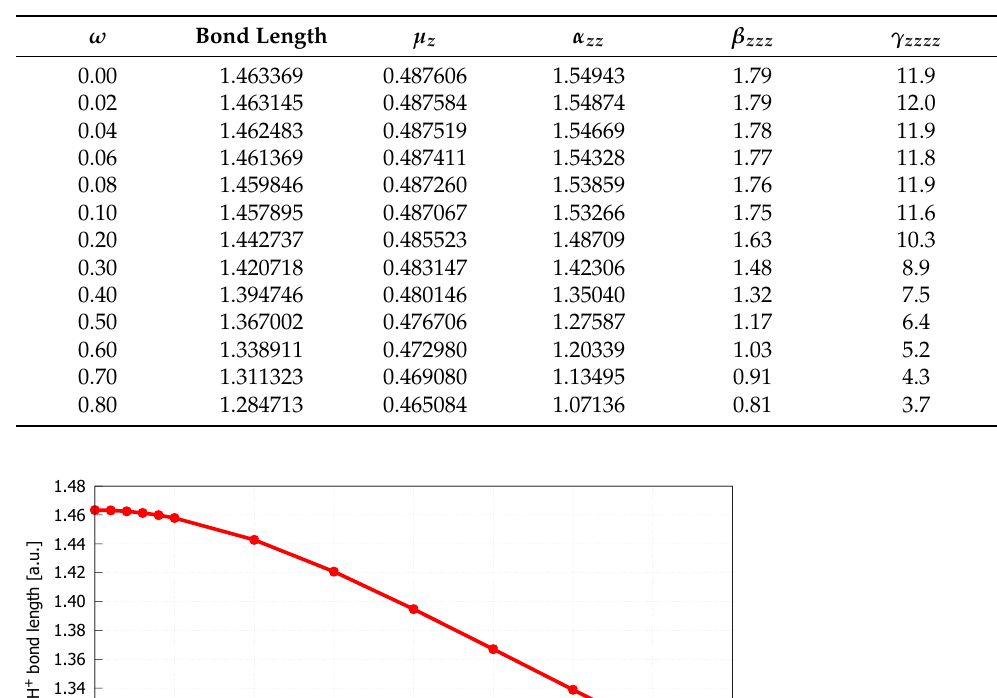
Table 2. Bond lengths, dipole moment ( µ z ), polarizability ( α zz ), first hyperpolarizability ( β zzz ) and second hyperpolarizability ( γ zzzz ) obtained at the CCSD/aug-cc-pV6Z level of theory for HeH + embedded in cylindrically symmetric harmonic oscillator potential of ω strength. All values are given in a.u.